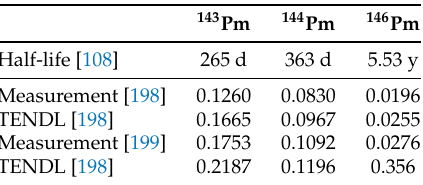
Table 5. Rates of production of long-lived radioisotopes induced in neodymium by protons at sea level. Measurements from Refs. [198,199] and calculations are presented (see text). All numbers are expressed in atoms/kg/day. 143